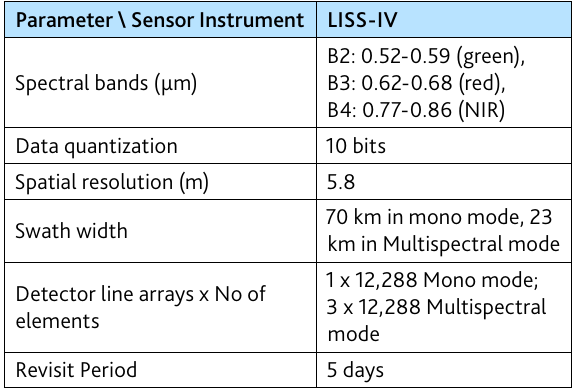
Table 1. Details of the LISS-IV multispectral images